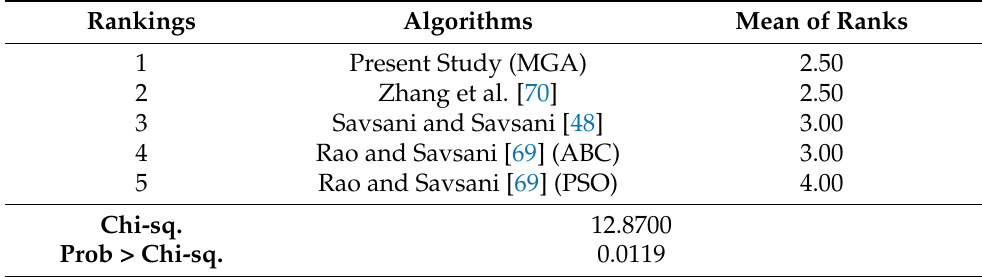
Table A14. Friedman statistical test results for the planetary gear train design problem.